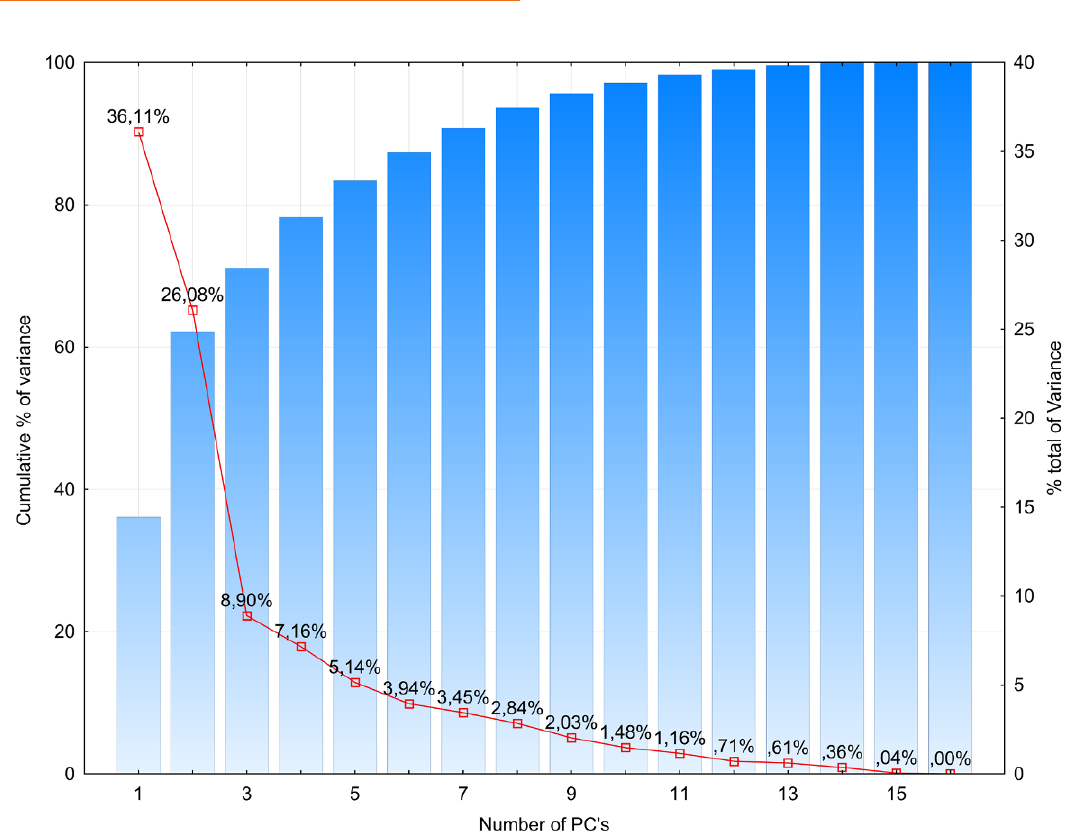
Figure 3. The scree test plot. Table 2. The values characterising the principal components designated for the data set.